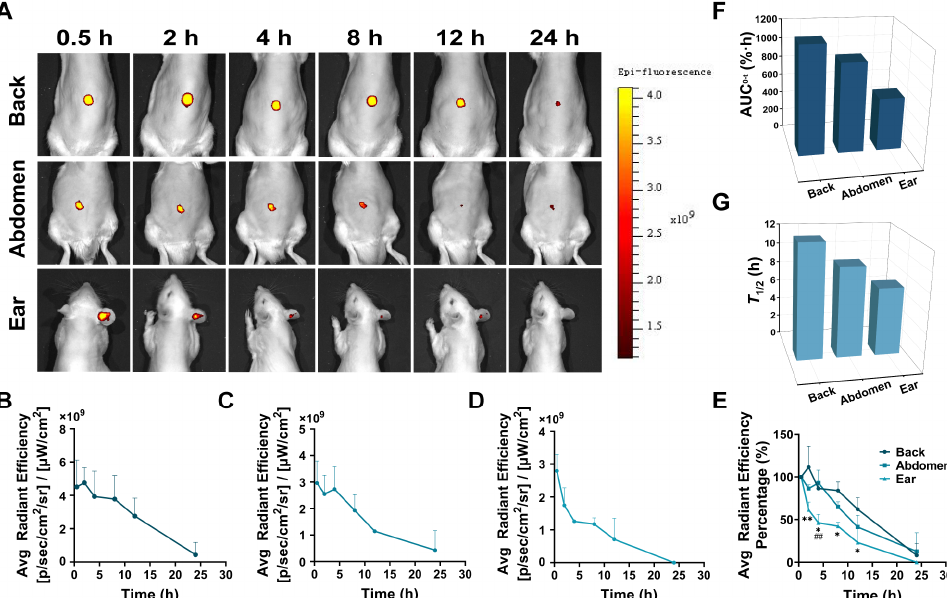
Figure 4. In vivo live imaging. ( A ) Representative live images of rats treated with P4 SLNs@DMNs at the skin of the back, abdomen, and ear. ( B – D ) Average fluorescence intensity of rats treated with P4 SLNs@DMNs at the skin of the back, abdomen, and ear ( n = 3). Data are expressed as mean ± SD. ( E ) The relative fluorescent intensity of rats treated with P4 SLNs@DMNs ( n = 3). Data are expressed as mean ± SD. Note: ** denotes p < 0.01 vs. group of back, * denotes p < 0.05 vs. group of back. ## denotes p < 0.01 vs. group of abdomen. ( F ) The AUC 0–t values and ( G ) T 1/2 values of relative fluorescent intensity of rats treated with P4 SLNs@DMNs at the skin of the back, abdomen, and ear.